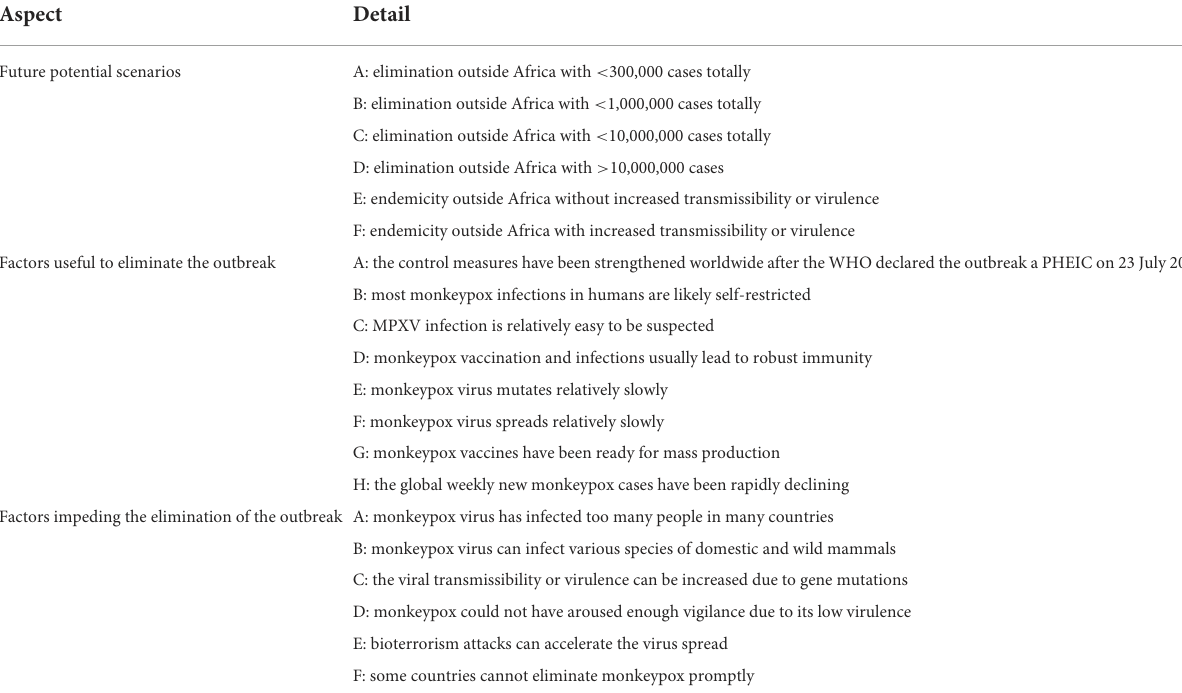
TABLE 1 Future potential scenarios, relevant factors, and elimination strategies of the monkeypox outbreak in 2022. Aspect